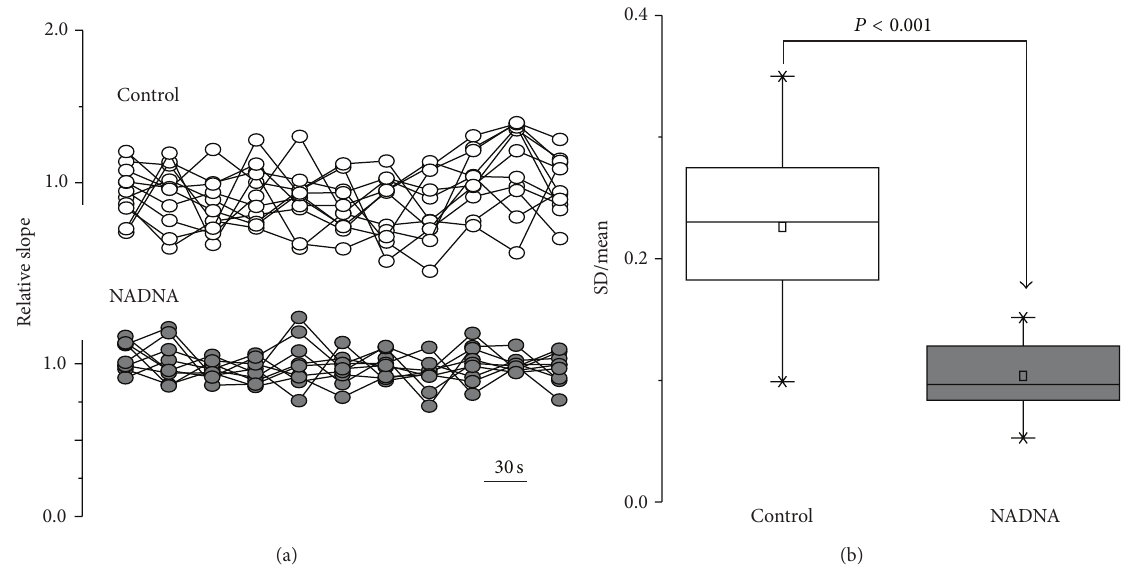
Figure 2: Effect of inhibition of NEU activity on variation of field potential response in hippocampal CA3-to-CA1 network. (a) Variation of baseline fEPSP recorded at 0.033 Hz in control and NADNA-pretreated slices. Each curve represents normalized to average baseline fEPSP slope from one slice. (b) Histogram shows that variation of baseline fEPSP slope significantly decreases in slices pretreated with NADNA.